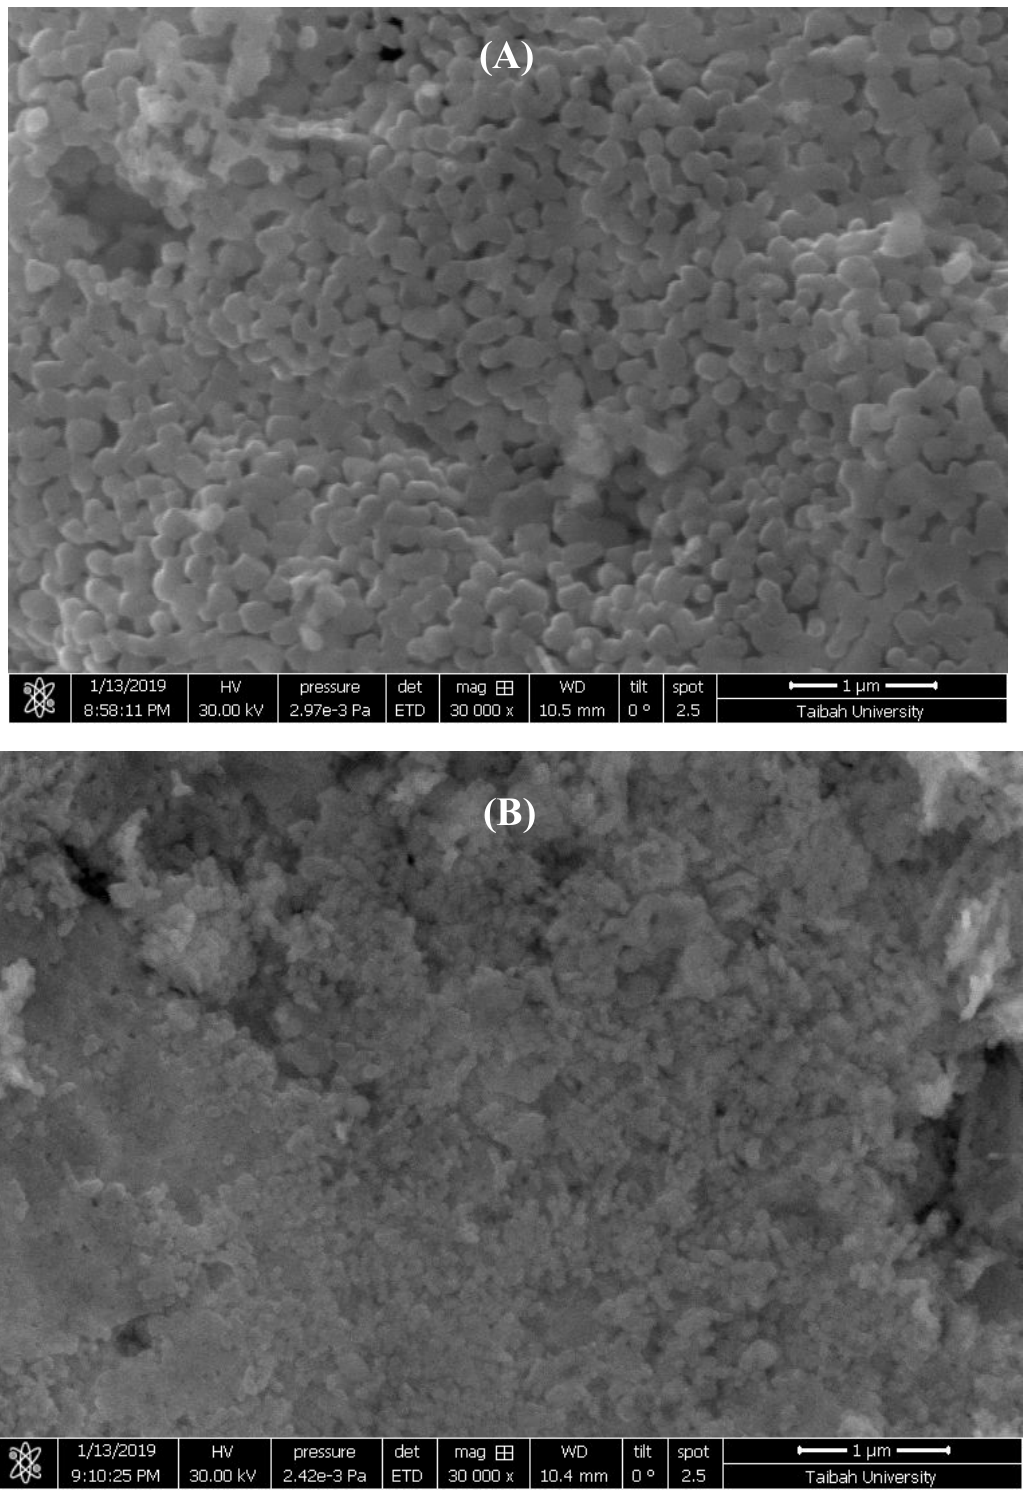
Figure 2. SEM images of pure (A), and CTAB-capped La 0.9 Sr 0.1 FeO 3 (B), with 30,000 times Figure2. SEMimagesofpure( A ),andCTAB-cappedLa 0.9 Sr 0.1 FeO 3 ( B magnification.